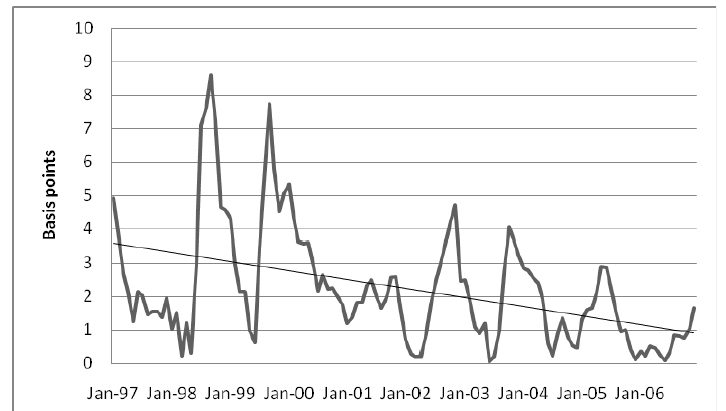
FIGURE 3: JIBAR 12-month-ahead forecast errors (absolute value, in basis points), 1997-2006